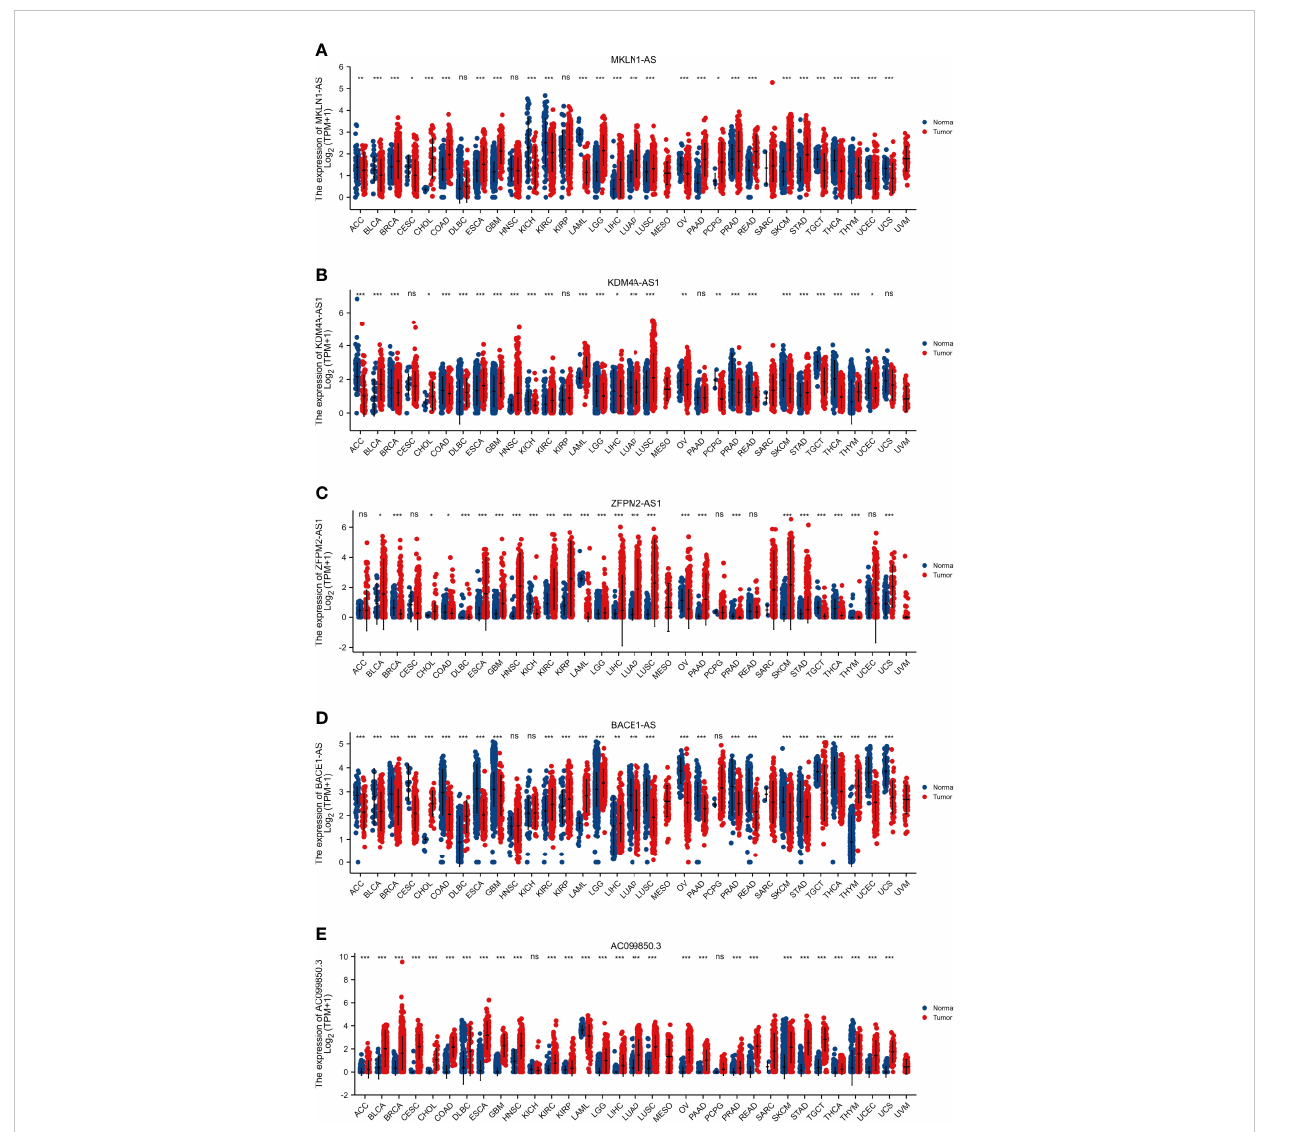
FIGURE 12 Pan-cancer analysis of the expression of fi ve ferroptosis- and necroptosis-related lncRNAs. (*P < 0.05, **P < 0.01, ***P <